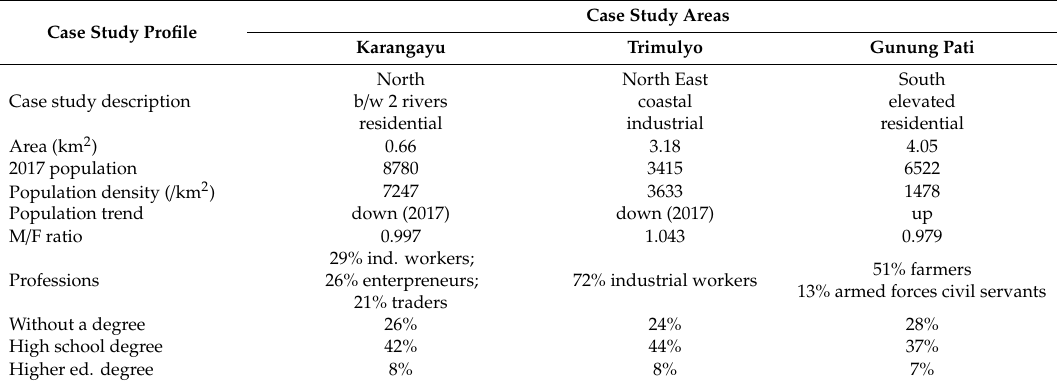
Table 1. Social profile of Semarang’s three case study areas (2017 data from Semarang Central Bureau of Statistics [39]).